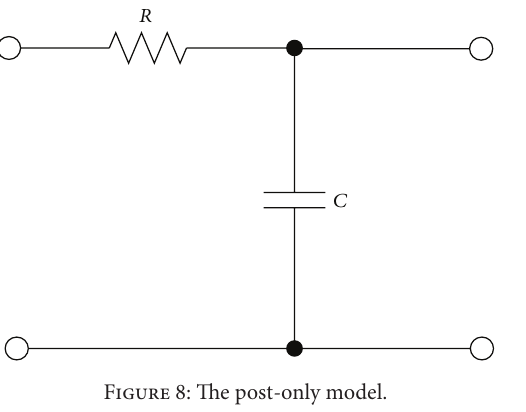
Figure 8: The post-only model.